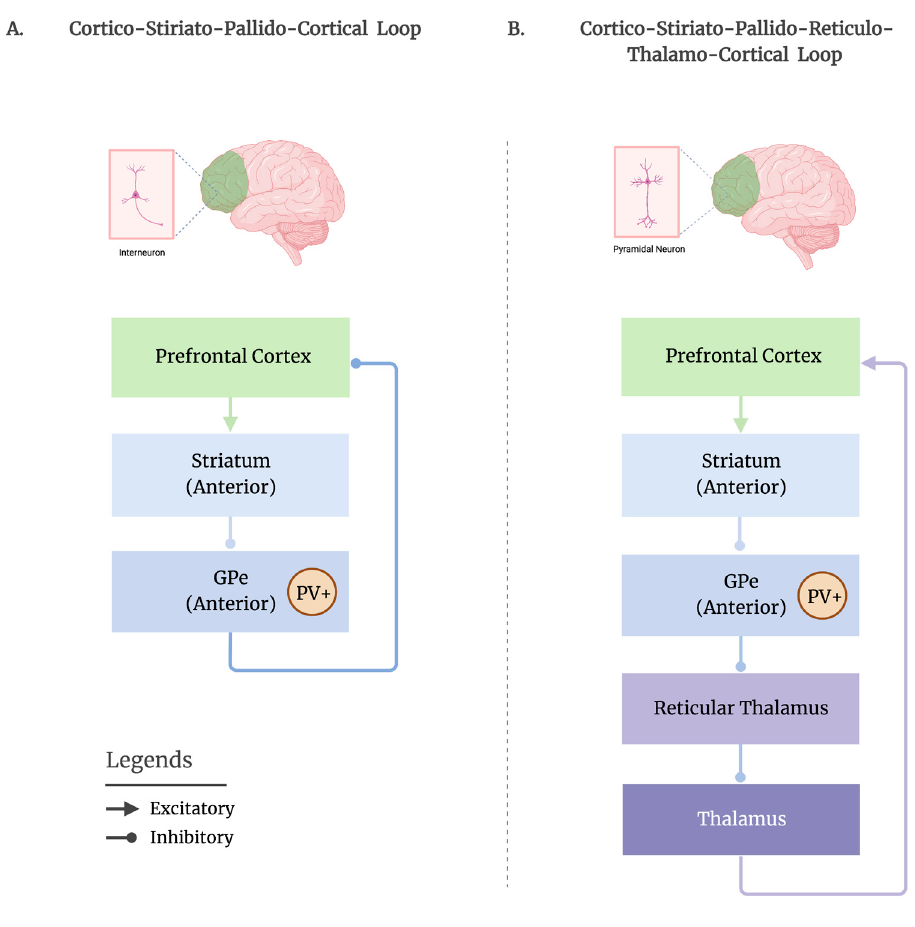
Figure 1. Two potential routes by which the GPe may mediate cortical activity are proposed. ( A ). Fol- lowing an anterior (rostral) topographical organization, the frontal cortex sends excitatory projections to the anterior portion of the dorsal striatum (caudate, putamen), which then sends inhibitory pro- jections to the anterior GPe, where the PV+ neurons reside. The inhibition of the GPe may lead to the disinhibition of the frontal GABAergic interneurons, permitting them to suppress the firing of pyramidal cells to promote sleep, via the direct pallido-cortical route. ( B ). Another route by which the GPe may influence sleep could be through its connections with the thalamic reticular nucleus (TRN) (i.e., reticular thalamus). Following the striatal inhibition of the GPe, the GPe releases its inhibition on the TRN. Then, the TRN is free to suppress (i.e., gate) the thalamo-cortical neurons and prevent the excitation of pyramidal cells in the cortex to disrupt sleep. Figure is adapted from “Basal Ganglia Motor and Non-motor Loops”, by BioRender.com, accessed on 29 December 2022. Retrieved from https://app.biorender.com/biorender-templates, accessed on 29 December 2022.